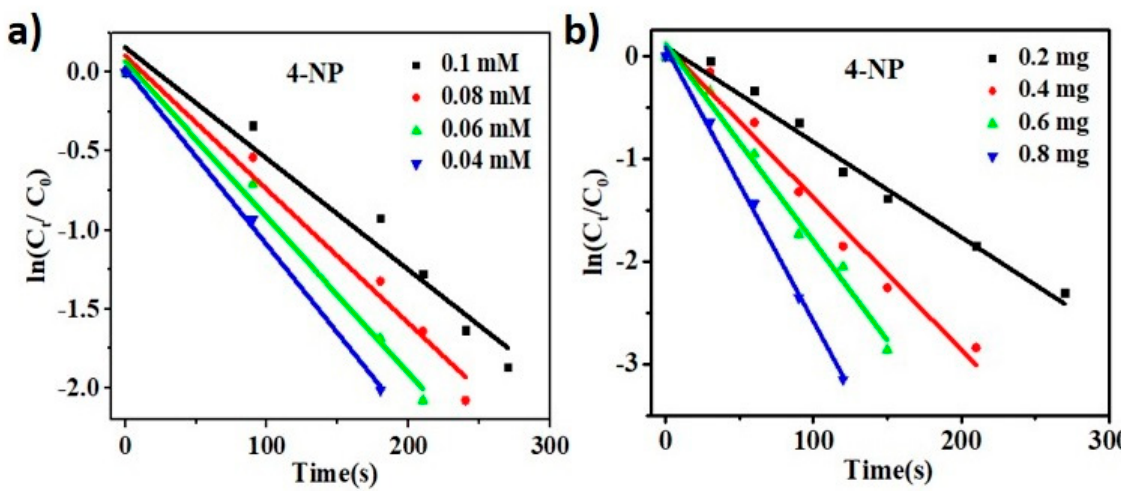
Figure 6. ( a , b ) The pseudo-first-order kinetic linear simulation curves.